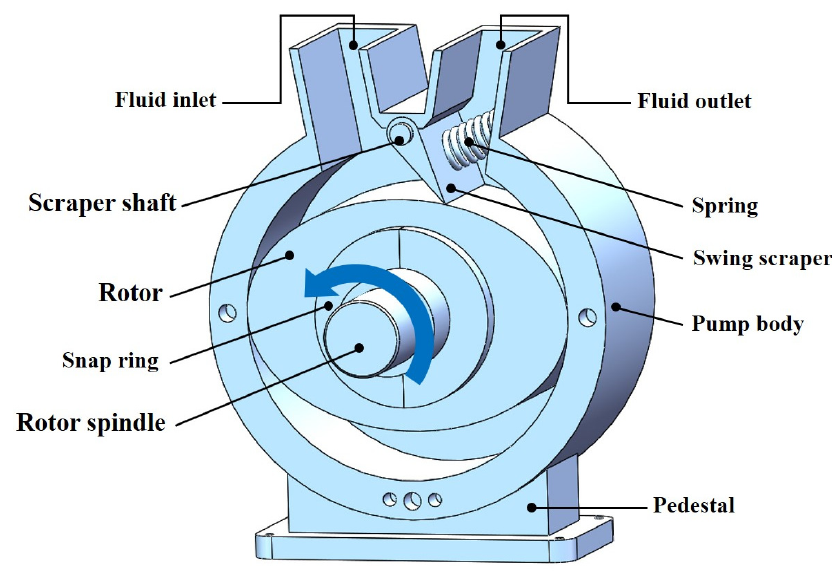
Figure 1. The 3-D model of the Elliptical Rotor Scraper Pump (ERSP).